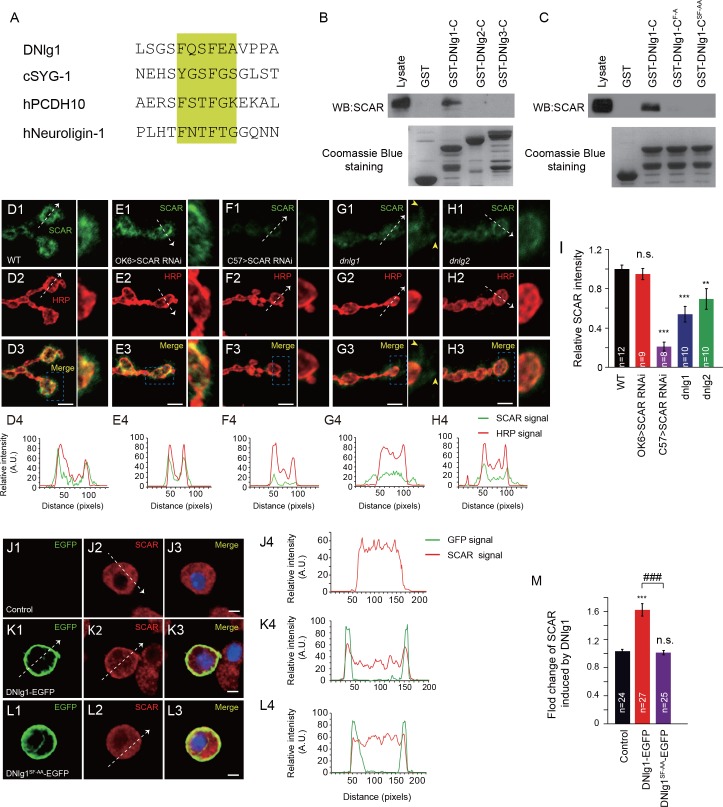
DNlg1, but not DNlg2 or DNlg3, binds to the WRC through its WIRS motif and recruits the WRC to the postsynaptic membrane.(A) Amino acid sequence alignment of DNlg1, C. elegans SYG-1 (cSYG-1), human PCDH10 (hPCDH10), and human Neuroligin 1 (hNeuroligin-1). The WIRS motifs are highlighted in yellow. (B) Lysates of WT fly brains were incubated with GST and GST-fused cytoplasmic domains of DNlg1 (GST-DNlg1-C), DNlg2 (GST-DNlg2-C), and DNlg3 (GST-DNlg3-C), respectively. The proteins pulled down with the GST or GST-fused proteins were analyzed by western blots using anti-SCAR antibody. Endogenous WRC was retained from the protein lysate by immobilized GST-DNlg1-C, but not by GST, GST-DNlg2-C, or GST-DNlg3-C. GST and GST-fused proteins were detected by Coomassie Blue staining. (C) Western blots showing that endogenous WRC was retained from fly-head lysates by immobilized GST-DNlg1-C, but not by the mutant forms of the WIRS motif GST-DNlg1-CF-A (F changed to A at the first amino acid residue in the WIRS motif) and GST-DNlg1-CSF-AA (SF changed to AA at the third and fourth amino acid residues in the WIRS motif). GST and GST-fused proteins were detected by Coomassie Blue staining. (D–H) Confocal images of (D) WT, (E) OK >SCAR RNAi (OK6-Gal4/+; UAS-SCAR RNAi/+), (F) C57 >SCAR RNAi (C57-Gal4/+; UAS-SCAR RNAi/+), (G) dnlg1 mutant (dnlg1ex1.9/ex2.3), and (H) dnlg2 mutant (dnlg2KO70/KO17) third instar larvae NMJ type Ib boutons labeled with anti-SCAR (green) and anti-HRP (red). The majority of SCAR protein was docked on the postsynaptic site. The loss of DNlg1 or DNlg2 caused a reduction in the level of SCAR. Line profile analyses show the distribution and intensity fluctuation of SCAR and HRP in each genotype. Dotted white lines indicate the regions analyzed in the line profile analysis. The directions are indicated by white arrows. Yellow arrow heads indicate diffused SCAR immunostaining signals in the dnlg1 mutants. (I) Summary graphs of the relative fluorescence intensity of SCAR signals in the indicated genotypes. (J–L) Low-density culture of (J) control S2 cells and (K) cells expressing DNlg1-EGFP or (L) the WIRS mutant form SF-AA (DNlg1SF-AA–EGFP) labeled with anti-SCAR and anti-GFP. SCAR was distributed throughout the cytoplasm of control S2 cells but was highly enriched at or near the cell membrane in the cells expressing DNlg1-EGFP, but not in those expressing DNlg1SF-AA-EGFP. Line profile analyses show that WT DNlg1, but not DNlg1SF-AA, induced the recruitment of SCAR to the plasma membrane and caused the co-localization of DNlg1 and SCAR. Dotted white lines indicate the regions analyzed in the line profile analysis. The directions are indicated by white arrows. (M) The ratio of SCAR intensity at the plasma membrane to that within the cytoplasm was calculated to indicate the recruitment of SCAR to the plasma membrane. A summary graph shows that WT DNlg1, but not DNlg1SF-AA, induced the recruitment of SCAR to the plasma membrane. The data in (I) and (M) are shown as the mean ± SEM; n represents the number of boutons analyzed; asterisks indicate significant differences between the WT and the indicated genotypes. **p<0.01; ***p<0.001; n.s., not significant. Hashes indicate significant differences between two indicated genotypes, ###p<0.001. Scale bars: (D–H) 5 μm, (J–L) 5 μm. A. U., artificial unit.10.7554/eLife.30457.011Figure 3—source data 1.Sample size (n), mean, SEM, and one-way ANOVA (and nonparametric) with Tukey's multiple comparisons test are presented for the data in Figure 3I and M.